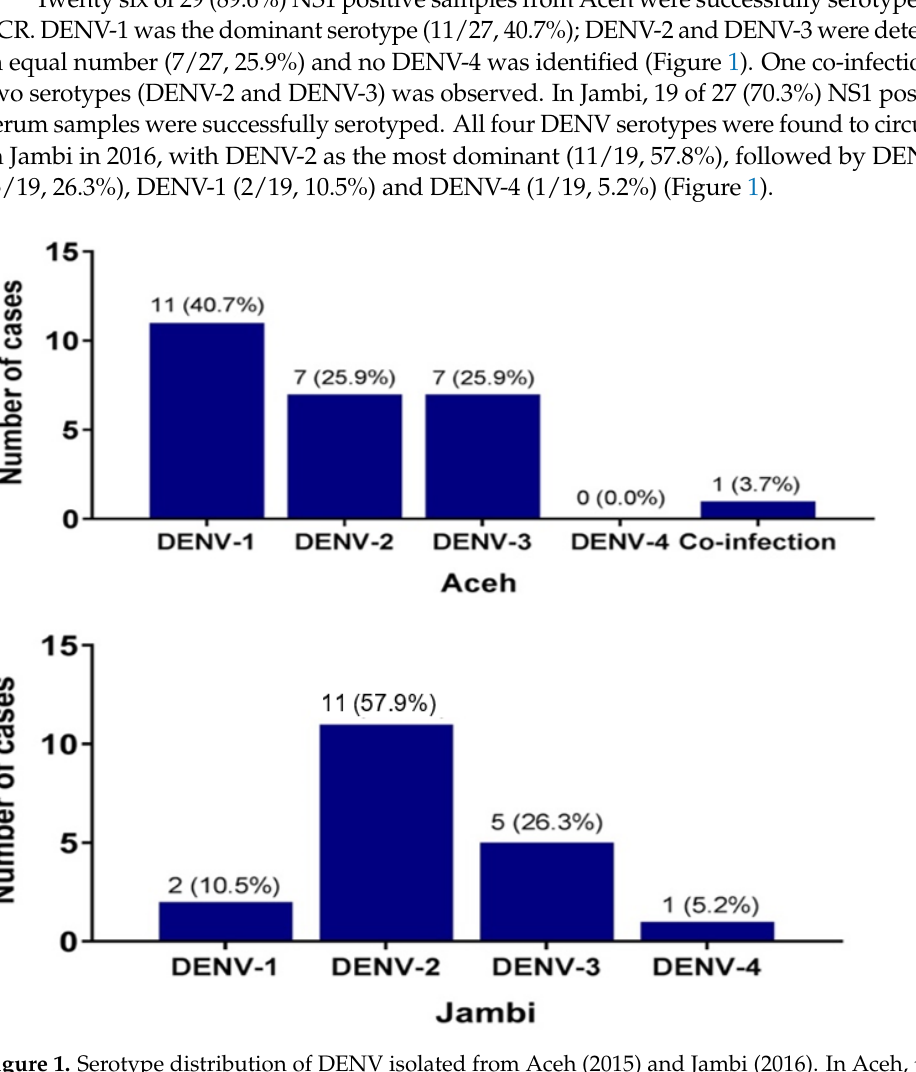
Figure 1. Serotype distribution of DENV isolated from Aceh (2015) and Jambi (2016). In Aceh, there was one co-infection of two serotypes (DENV-2 and DENV-3).